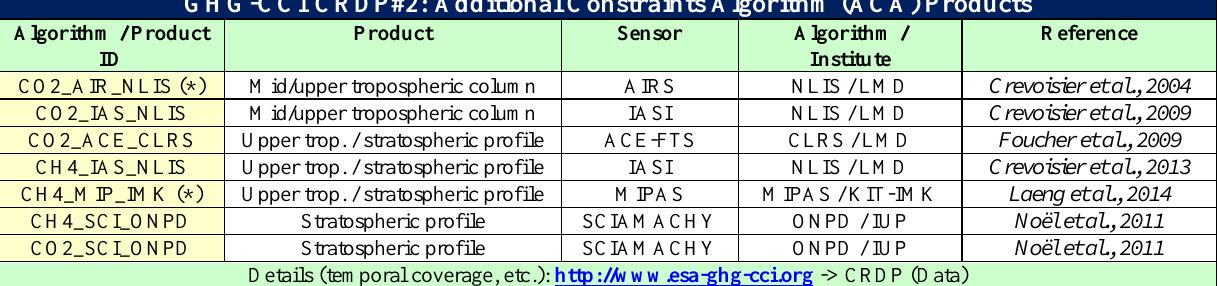
Tab. 2: Overview GHG-CCI ACA products providing information on CO 2 and CH 4 in atmospheric layers above the planetary boundary layer. (*) CRDP#1 product (no update for